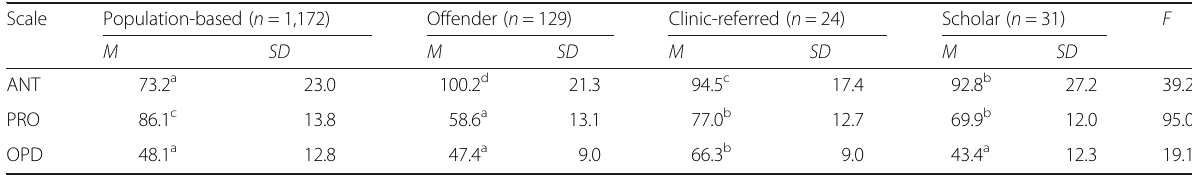
Table 2 ANOVAS and post-hoc tests Scale Population-based ( n = 1,172) Offender ( n = 129) Clinic-referred ( n =